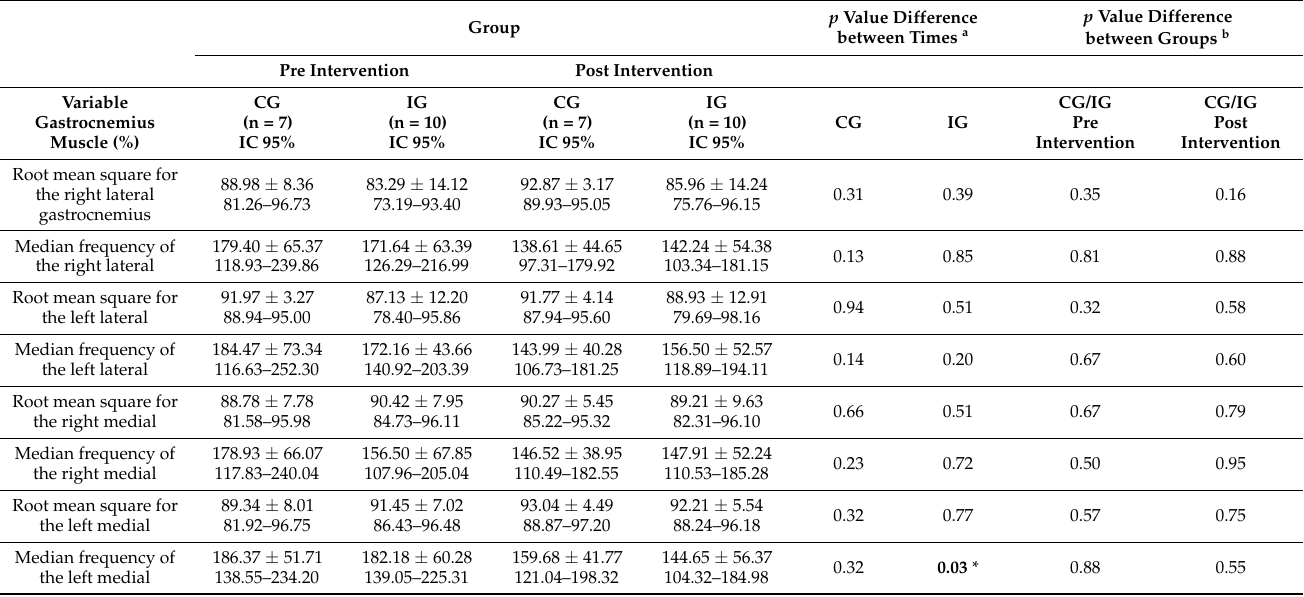
Table 2. Mean value, standard deviation and confidence interval in the comparison of GC and IG for electromyography variables in maximum voluntary isometric contraction.